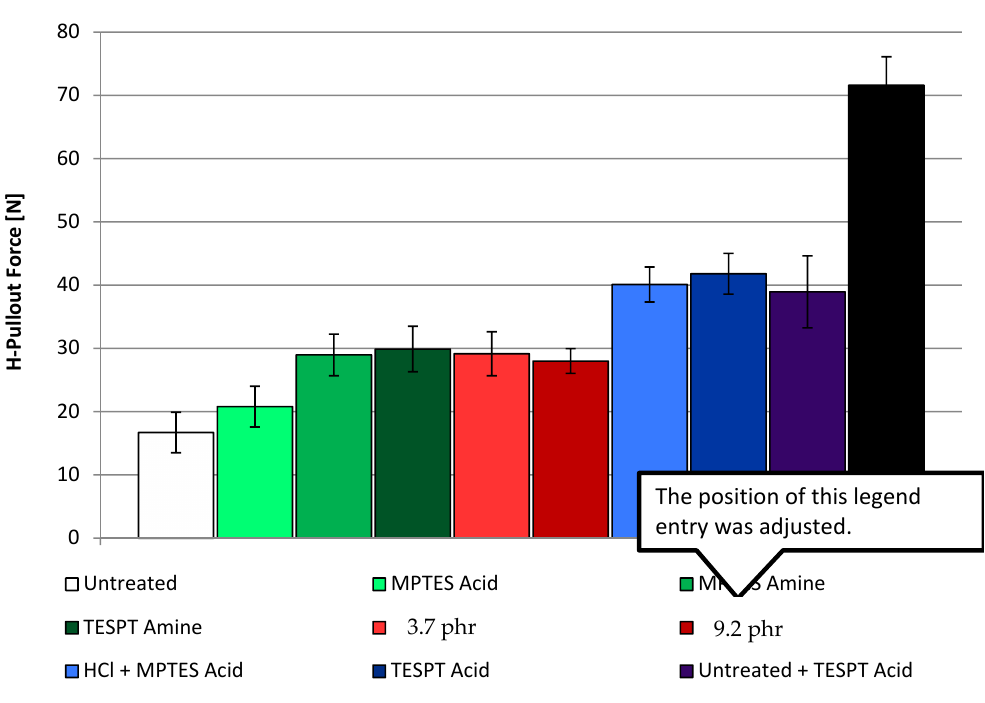
Figure 5. H-Pullout results for TEOS-plasma-coated rayon cords.